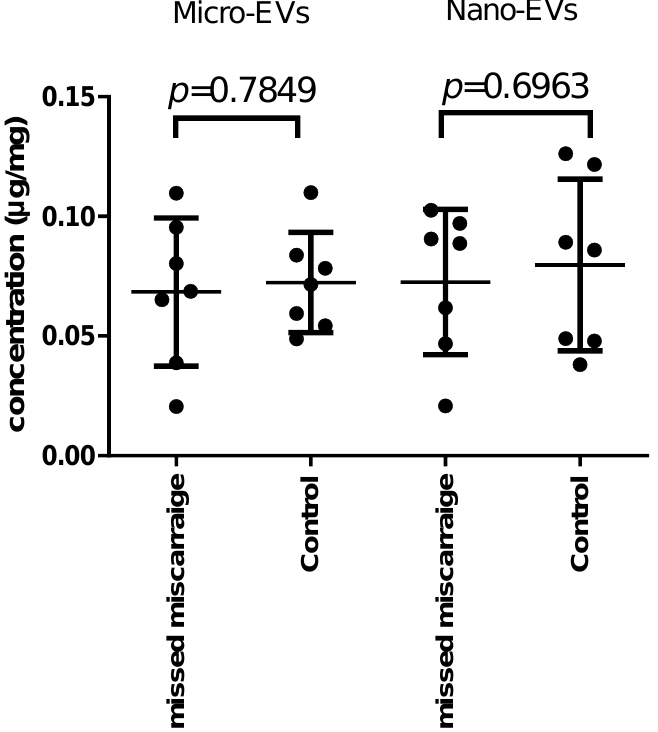
Figure 1. The concentration of proteins in micro-EVs and nano-EVs from missed miscarriage and healthy